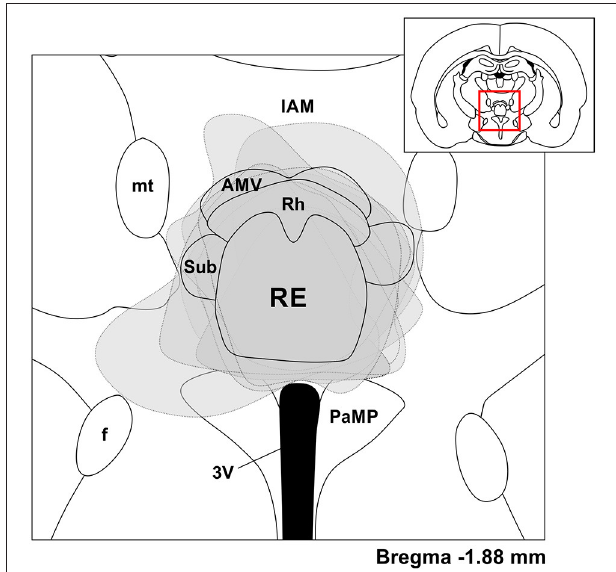
FIGURE 1 | Viral expression was largely confined to the nucleus reuniens (RE). Coronal schematic depiction of the ventral midline thalamus according to a rat brain atlas (Paxinos and Watson, 1998). Gray dashed lines and areas correspond to viral expression across individual experiments, transparent and overlaid on the same schematic, based on a position of − 1.88mm from bregma. Inset, Coronal schematic of the relative location (red box) of the expansion. IAM, interanteromedial nucleus of thalamus; mt, mammillothalamic tract; AMV, anteromedial thalamic nucleus, ventral part; Rh, rhomboid nucleus of thalamus; Sub, submedius nucleus of thalamus; RE, reuniens nucleus of thalamus; f, fornix; 3V, third ventricle; PaMP, paraventricular hypothalamic nucleus, medial parvicellular